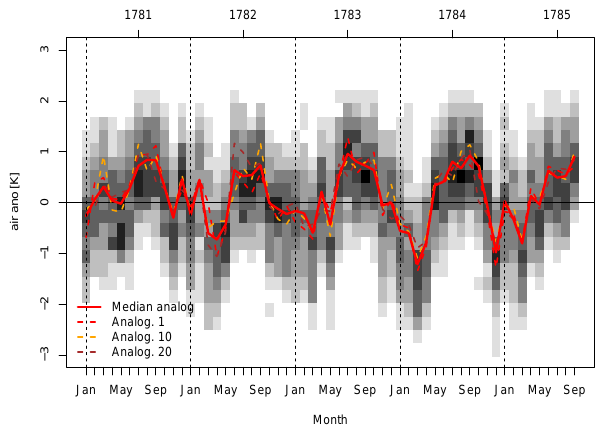
Fig. 5. Median of 20 surface air temperature anomaly reconstruc- tions for France in 1783–1784 (red line, in K). The grey squares represent the monthly probability distribution of the 20 analogue